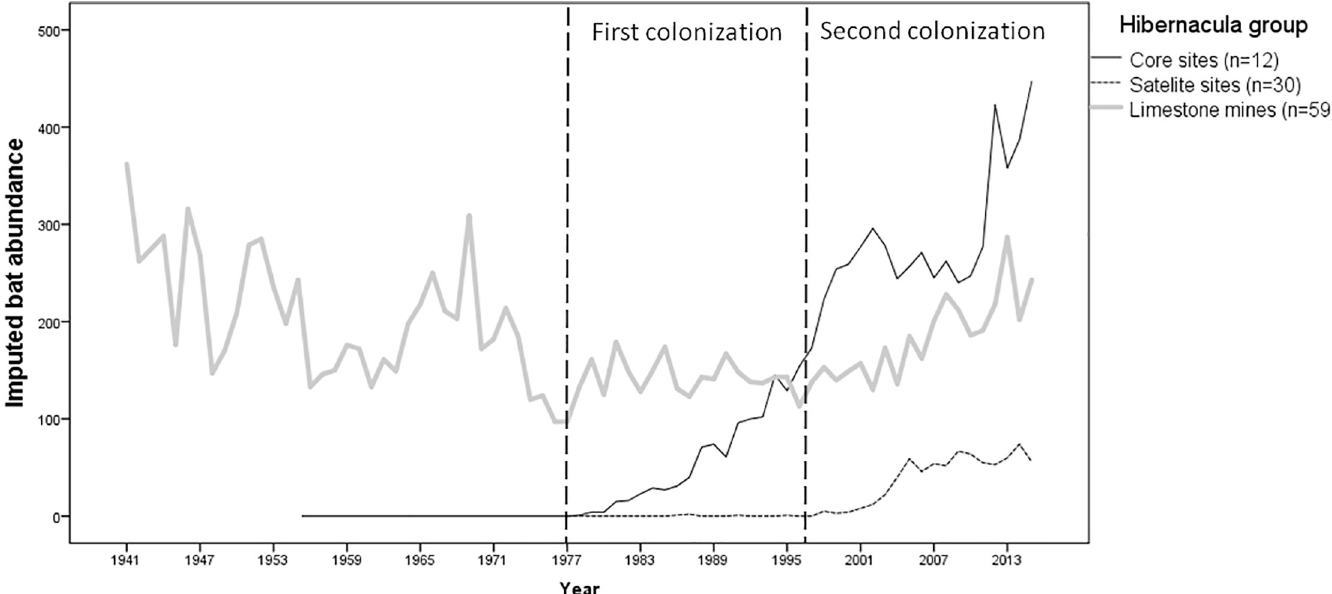
Fig 2. The (imputed) total annual abundance of pond bats in hibernacula in the provinces of Gelderland, Zuid-Holland and Limburg. The three lines represent three groups of hibernacula; core sites (12 roosts, unbroken line), satellite sites (30 roosts, broken line) and limestone mines (59 roost, grey line).